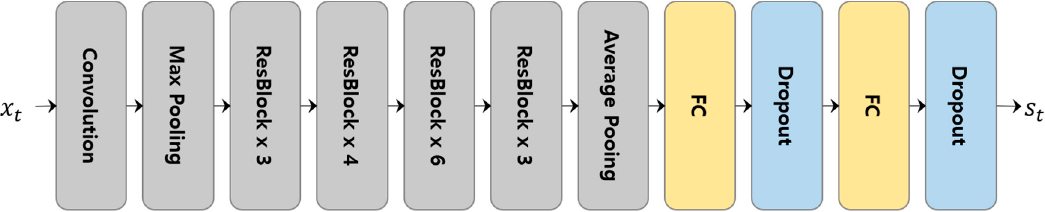
Figure 4. Modified ResNet50 structure for extracting smoke features. Here, x t represents the t th input region and s t represents the 1024-dimensional output feature vector for the